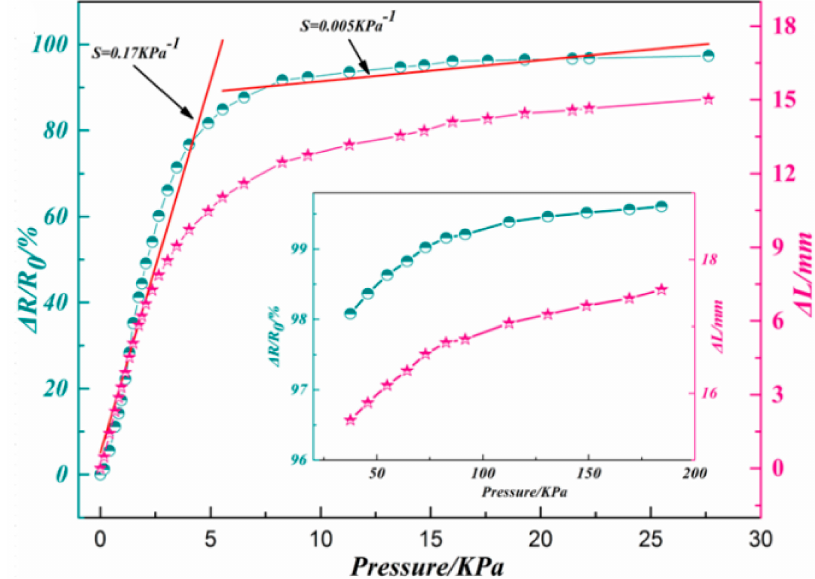
Figure 5. Relative resistance changes and compression amounts of reduced graphene oxide / polyurethane (rGO / PU) composite foam under pressure bellow 30